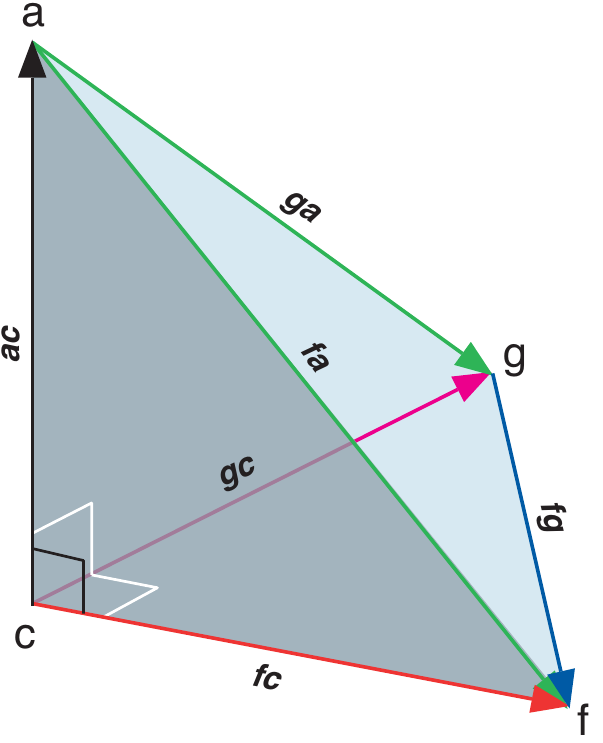
Fig. 3. Illustration of two forecasts – (g) and (f) – and observa- tions (a) . Forecast errors (green line) represents the difference be- tween forecast and analysis. Jumpiness are expressed as blue line indicating the difference between two forecast.